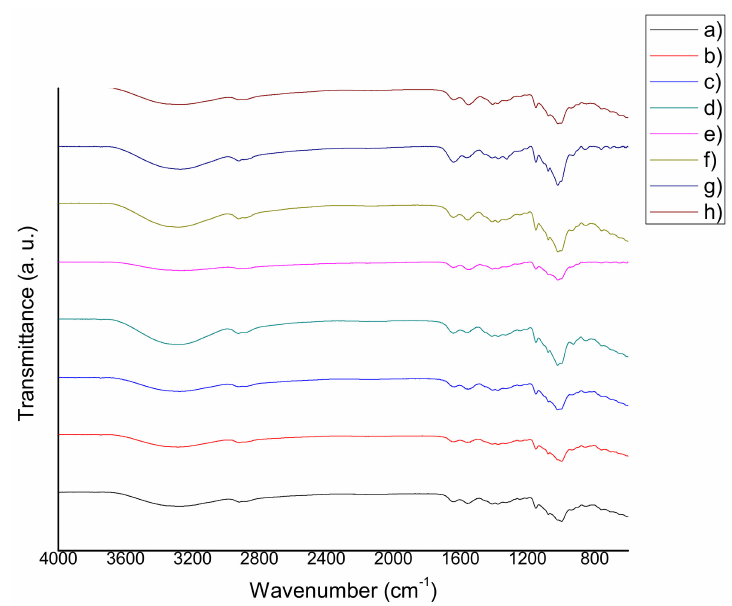
Figure 3. FTIR spectra of ( a ) QS2 vs. ( b ) QSA2; ( c ) QSAm2; ( d ) QSB2; ( e ) QSG2; ( f ) QSO2; ( g ) QSP2; and ( h ) QSR2.